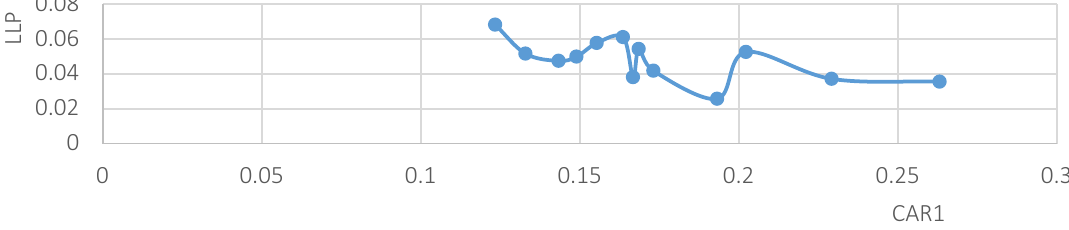
Figure 3. Capital adequacy ratio (CAR1) and credit risk (LLP)